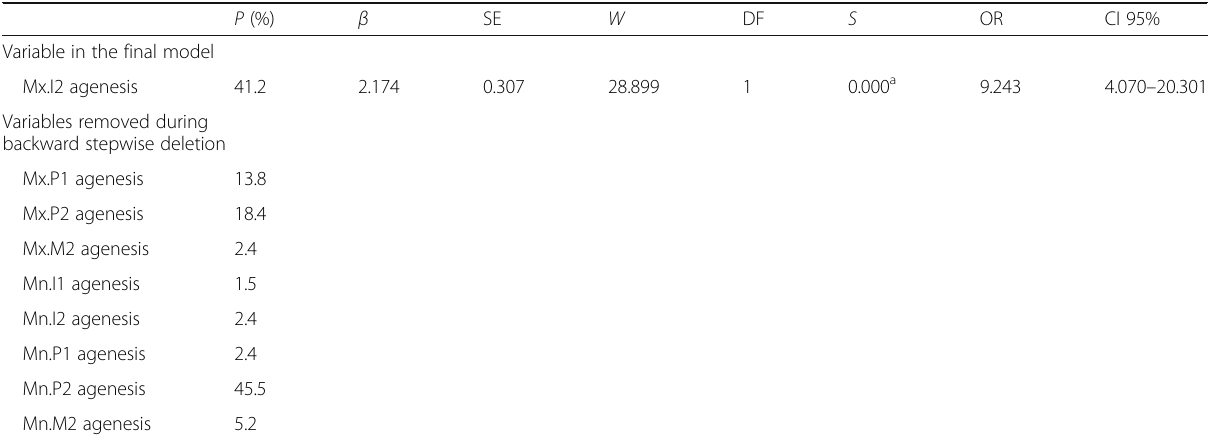
Table 3 Distribution of missing teeth and statistical association with displacement of maxillary canine P (%) β SE W DF S OR CI 95% Variable in the final